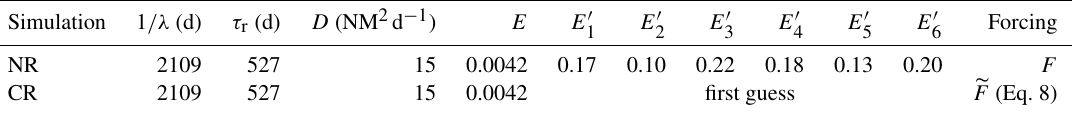
Table 1. SEAPODYM-MTL parameters used for the two different simulations: the nature run (NR) and the control run (CR). E is the energy transferred by net primary production to intermediate trophic levels, λ is the mortality coefficient, τ r is the minimum age to be recruited in the midtrophic functional population, and D is the diffusion rate that models the random dispersal movement of organisms. E (cid:48) the redistribution energy transfer coefficients to the six components of the micronekton population. The parametrization of the NR is called the reference parametrization and is taken from Lehodey et al.